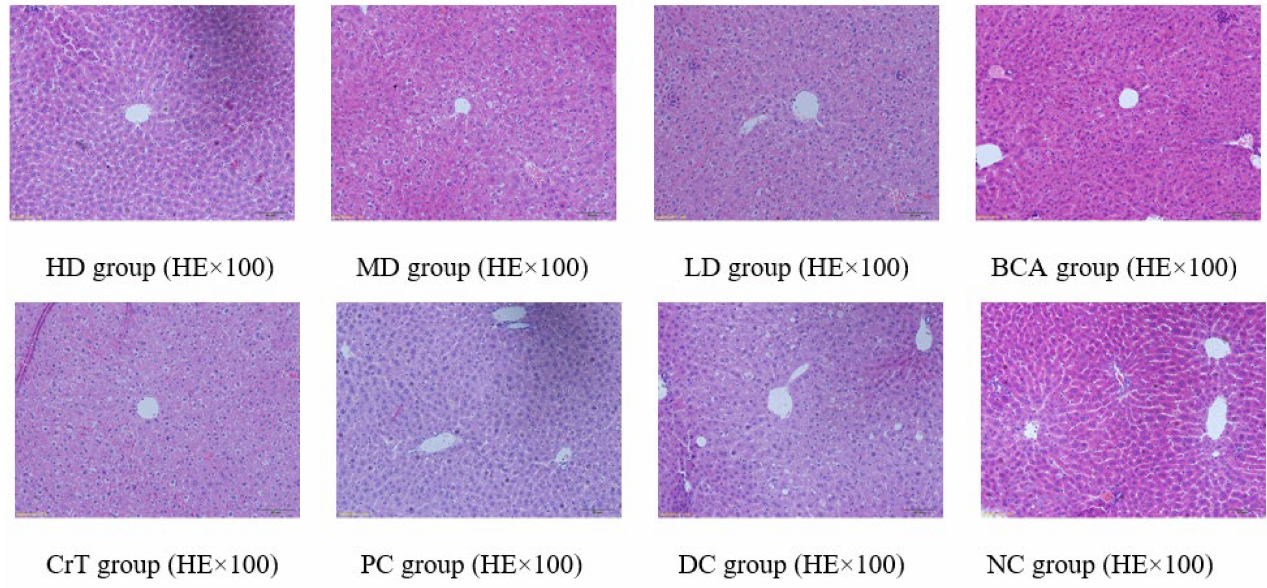
Figure 11. Morphological changes in liver